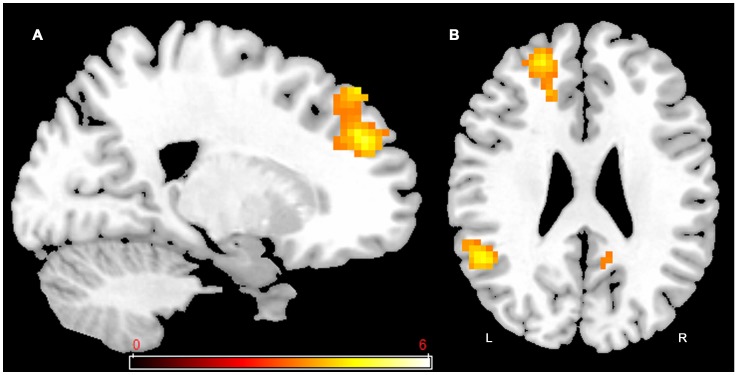
Activation-related to modulation of attention prior to training (pre-training session).Subtracting dual-task 80% Equation (80/20) from dual-task 20% Equation (20/80) involves activation in the left superior and medial frontal gyrus (A and B), and left superior temporal and left cingulate gyrus (B). The threshold for display is P<0.001, uncorrected, 10 voxels. Coloured bar is representative of t scores mentioned in table 5. “L” denotes the left side of the brain, while “R” denotes the right side.